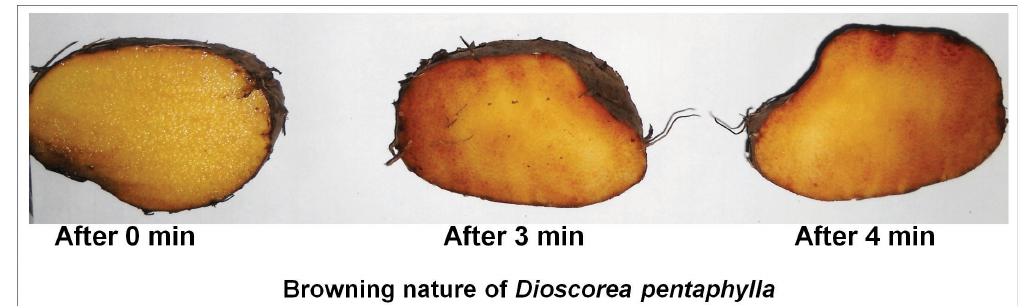
FIGURE 3 - Browning properties of D.